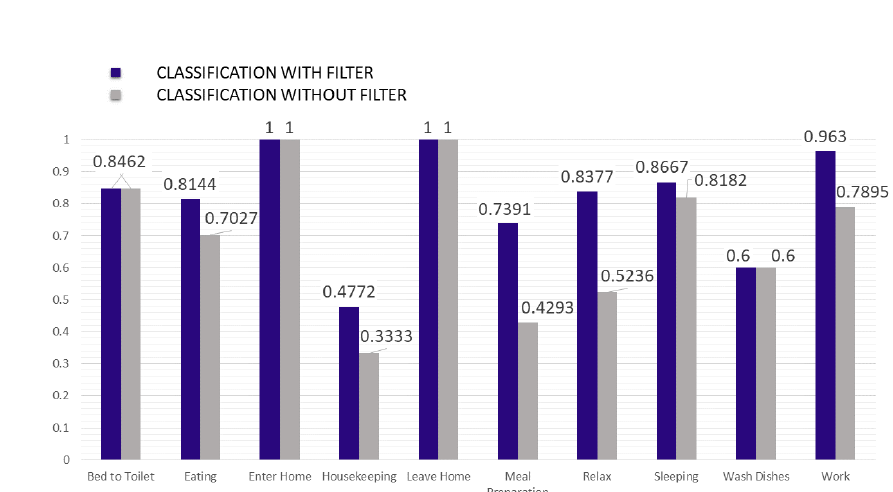
Figure 6. Comparison between activity recognition accuracy in percentage with and without the filter. The classification without the filter corresponds to the algorithm in [9].